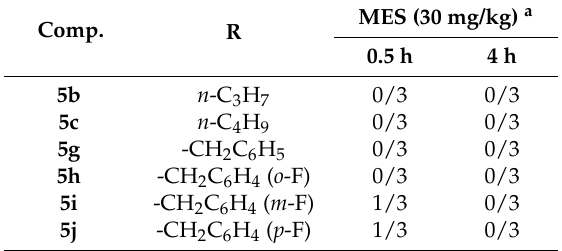
Table 2. Anticonvulsant activities screening: MES test in mice at the dose of 30 mg/kg. Comp. MES (30 mg/kg) Comp. R